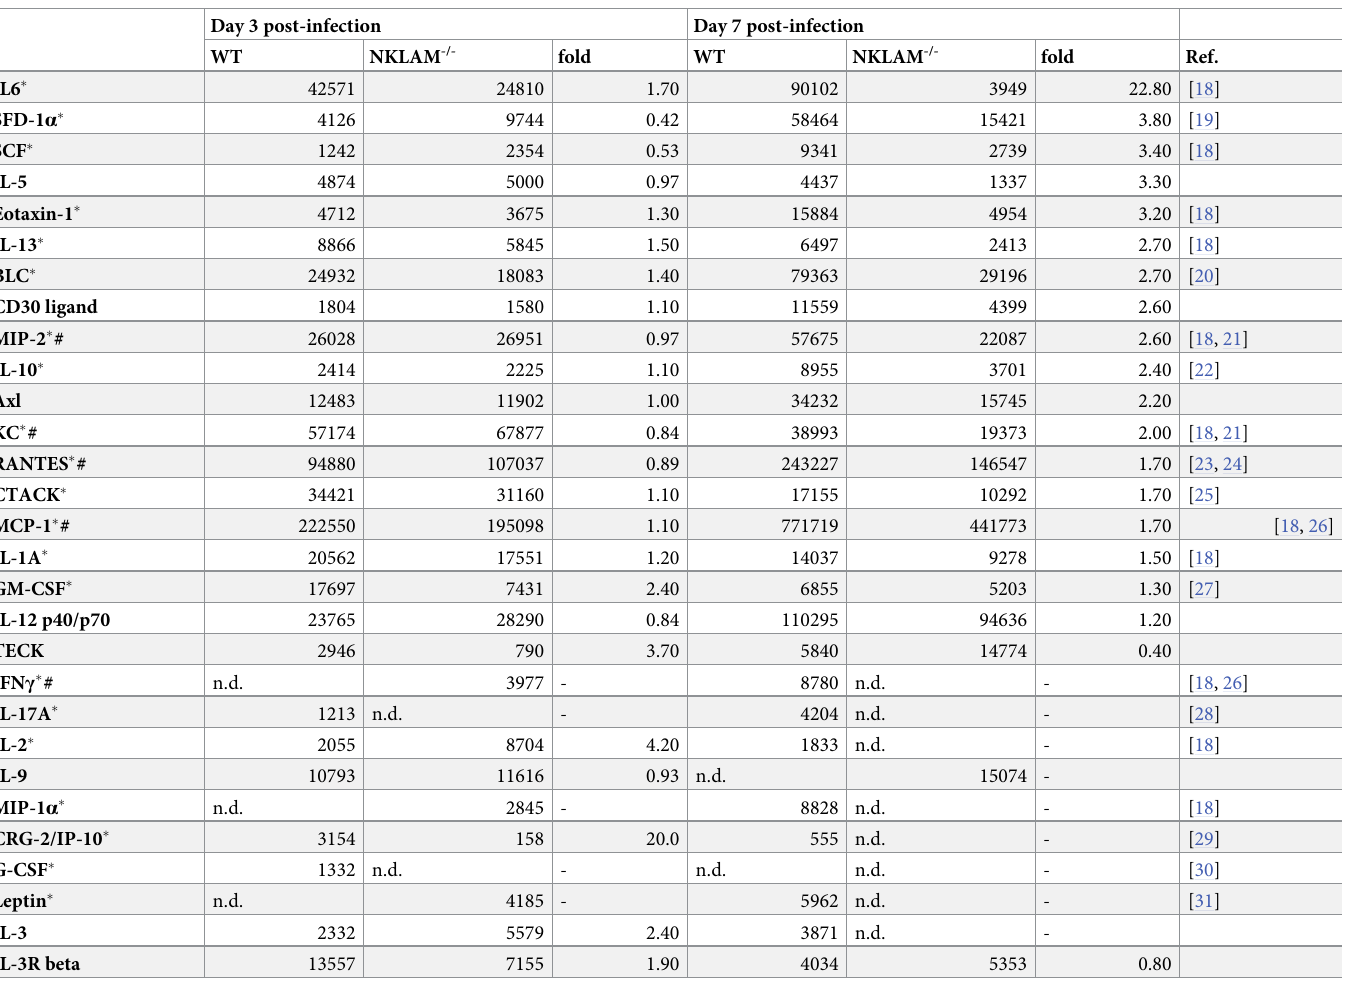
Table 1. Cytokine and chemokine expression in SeV-infected WT and NKLAM -/- lungs. Day 3